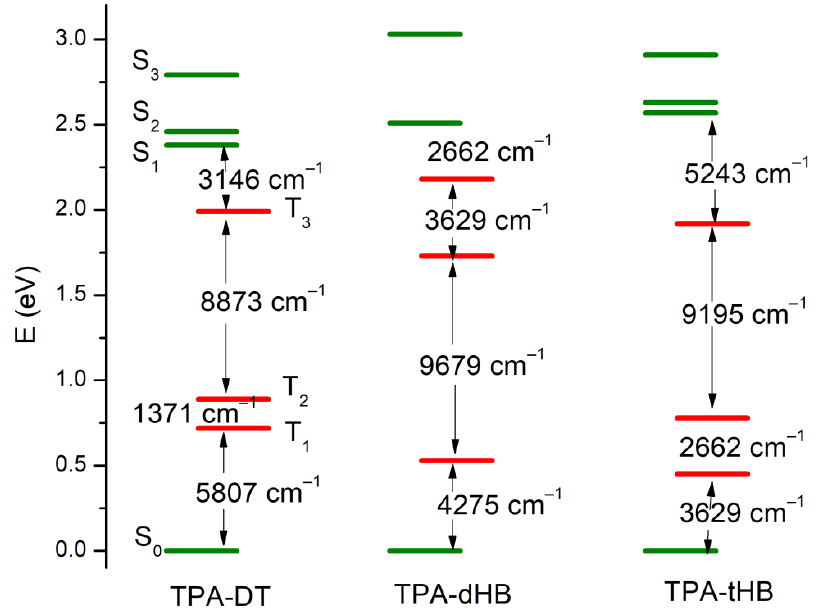
Figure 5. Low-lying energy states in TPA molecules (green lines — the singlet excited states and red lines — triplet excited states).